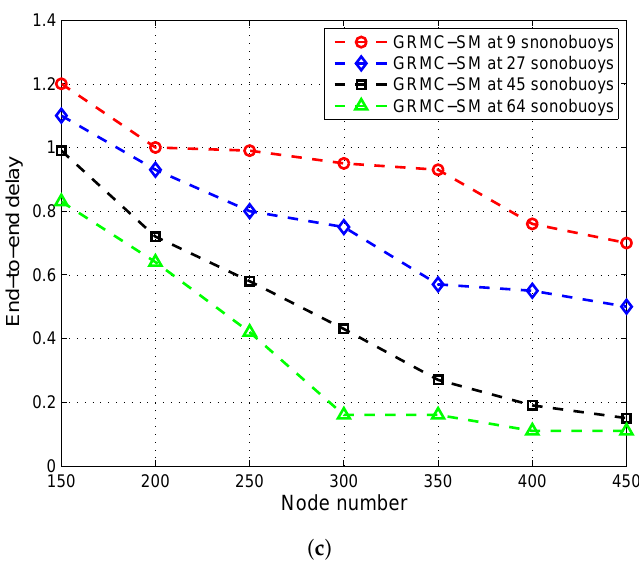
Figure 14. Performance parameters for GRMC-SM. ( a ) Fraction of void nodes under different number of sonobuoys; ( b ) PDR under different number of sonobuoys; ( c ) end to end delay under different number of